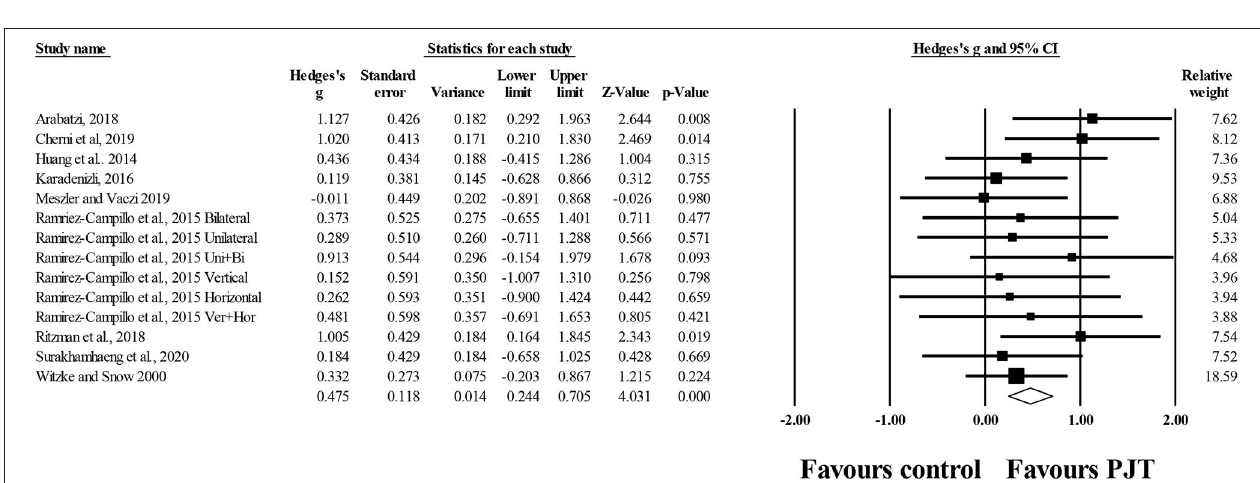
FIGURE 8 | Forest plot of changes in static balance, measured through laboratory-based equipment, in participants that completed a plyometric jump training (PJT) program compared to participants allocated as controls. Values shown are effect sizes (Hedges’s g) with 95% confidence intervals (CI). The size of the plotted squares reflects the statistical weight of each study. The diamond reflects the overall